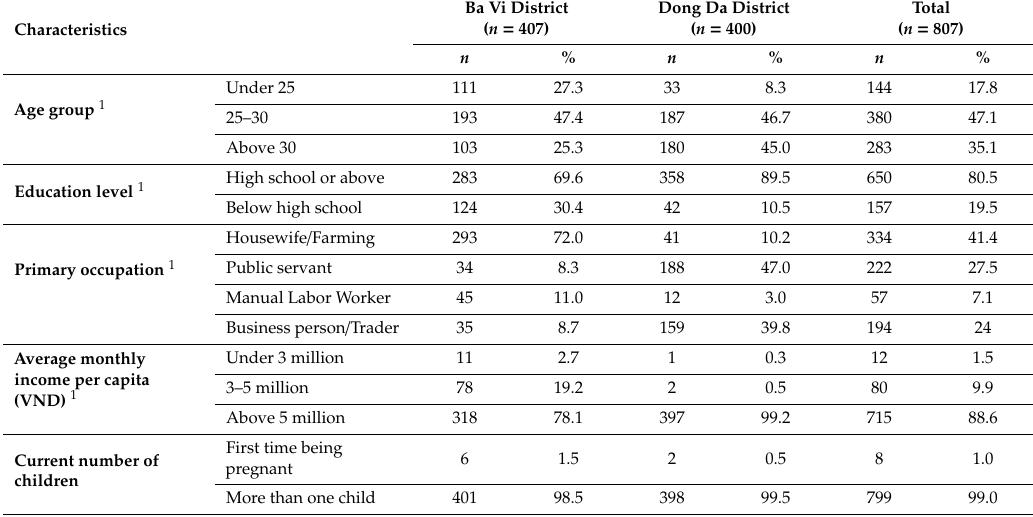
Table 1. Demographic characteristics of participants.